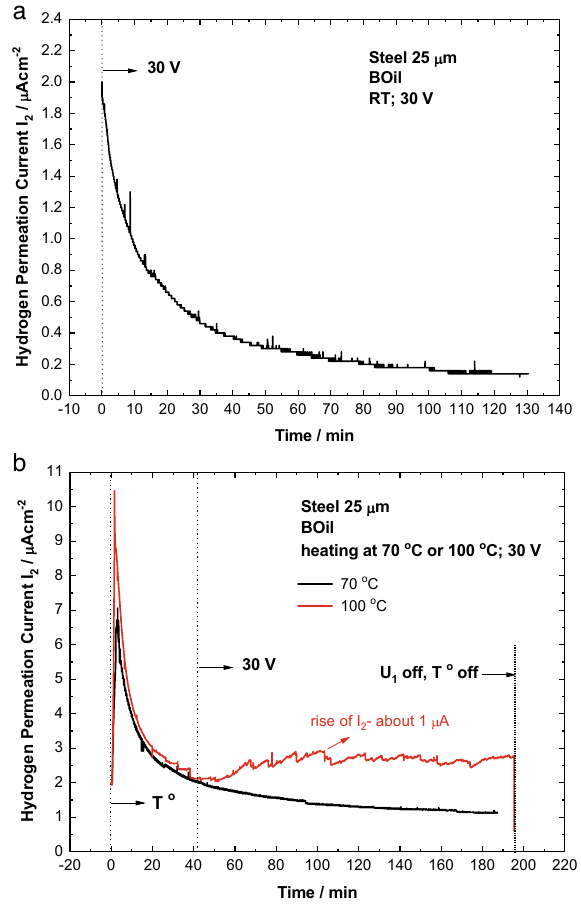
Figure 2. Hydrogen permeation transients, recorded with BOil under voltage of 30 V at room temperature ( a ); upon heating at 70 °C or 100 °C ( b